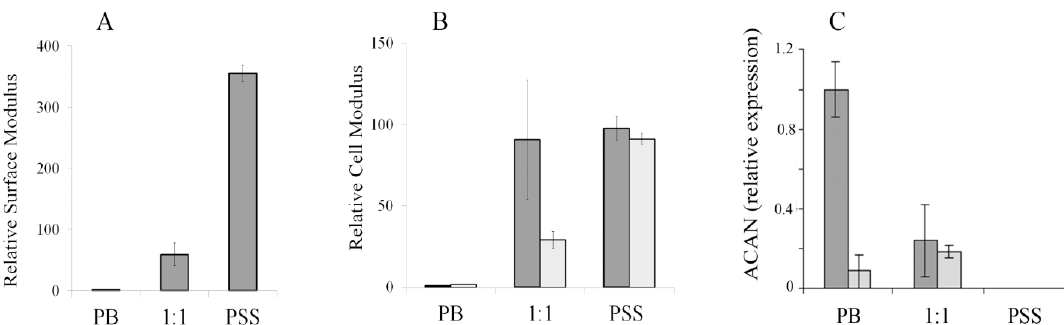
Figure 7. Scanning modulation force microscopy (SMFM) was carried out on ( A ) PB, PSS 28 , and a 1:1 blend of PB and PSS 28 (1:1) and on ( B ) live cells cultured on these substrates for 4 days in DOXY − / rhBMP2 + medium (dark gray bars) or DOXY + / rhBMP2 − medium (light gray bars). ACAN mRNA expression ( C ) was evaluated after 14 days of growth.